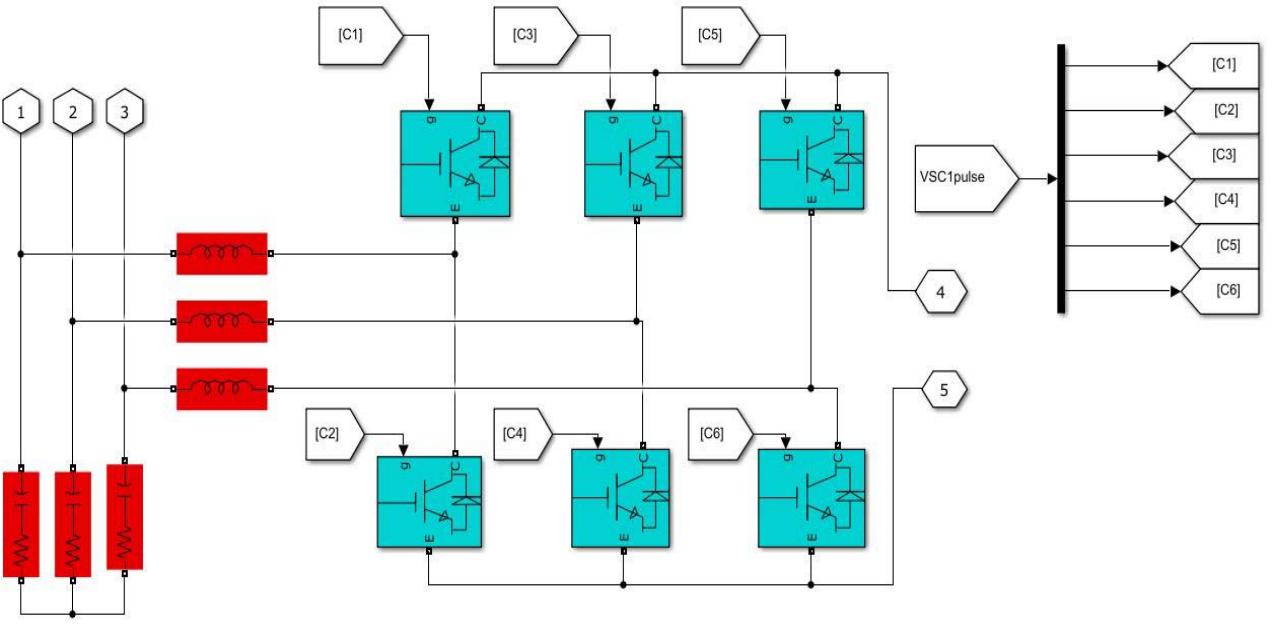
Figure 2. Series inverter with LC filter.